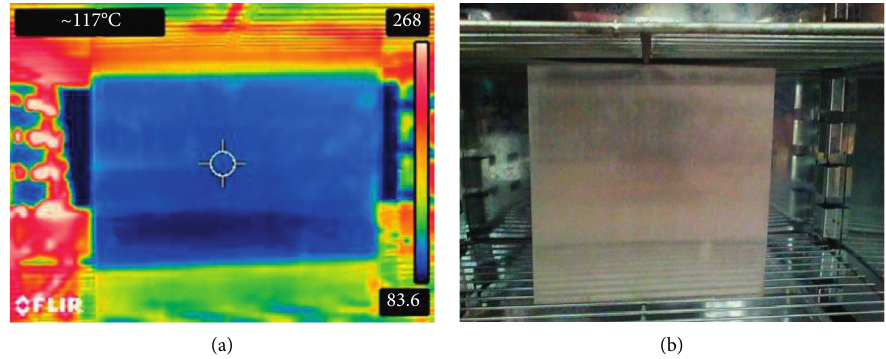
Figure 11: Hot air heating experiment of the electro-magnesium alloy without cathodic protection.